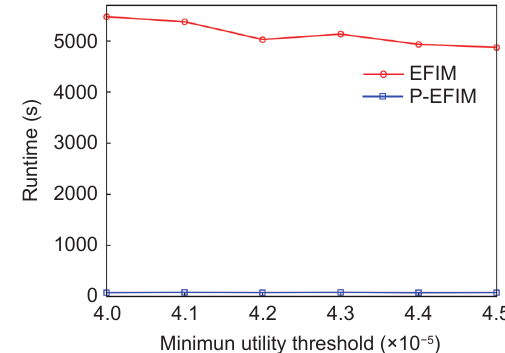
Fig. 6 Comparison on runtime between EFIM and P-EFIM on Chainstore